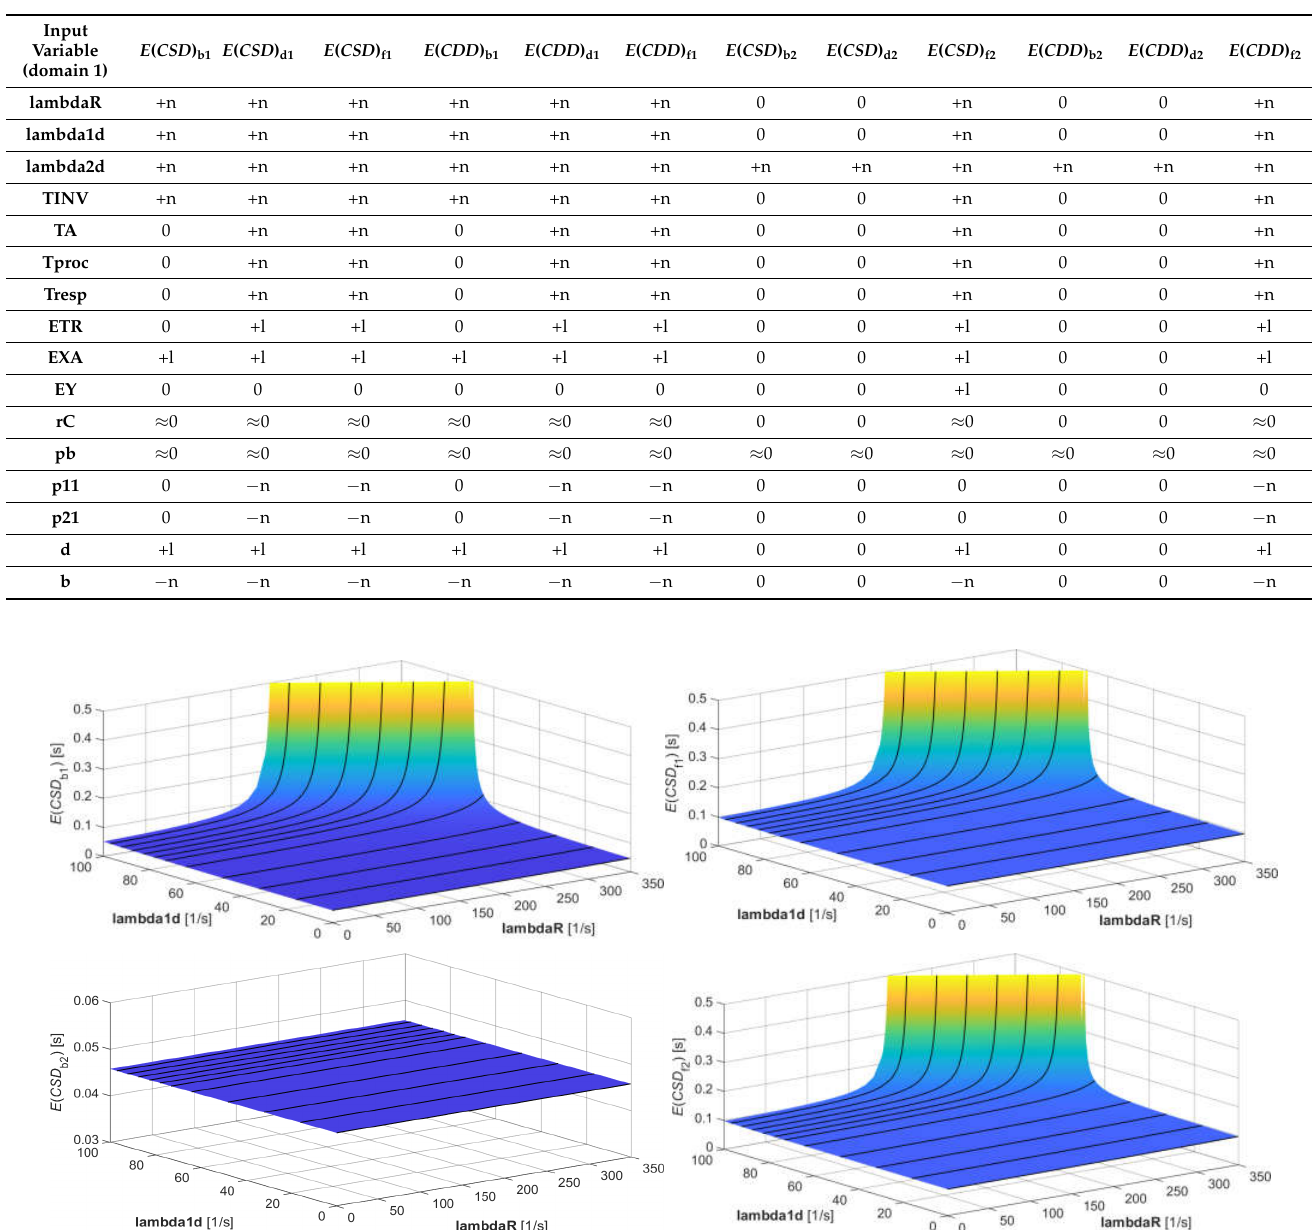
Table 3. Impact of changing input variables in domain 1 on CPP parameters in both domains.